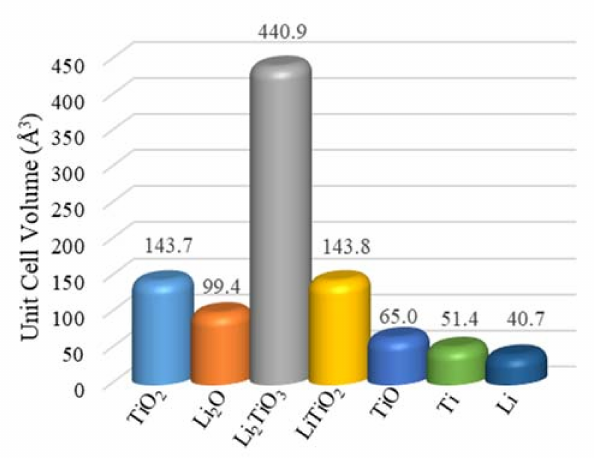
Figure 6. Unit cell volumes for the related chemicals during the TiO 2 electrolytic reduction in the molten LiCl–Li 2 O (1 wt.%) at 650 ◦ C.